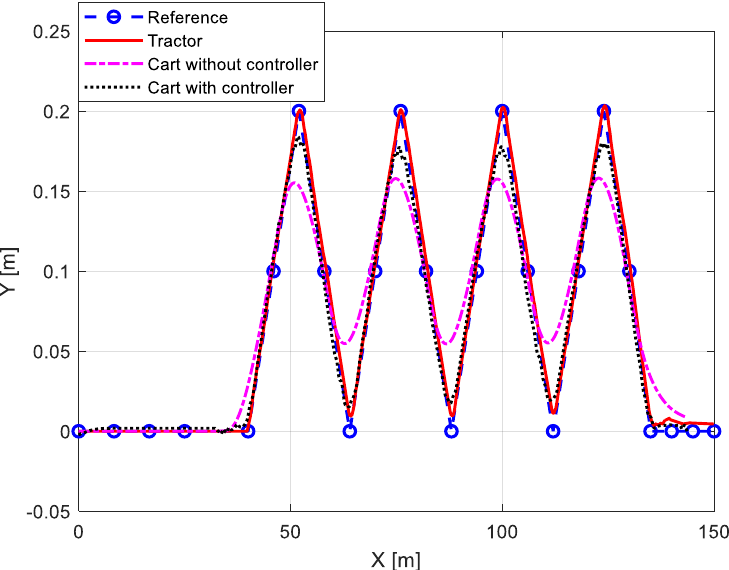
Figure 13 . Performance of tractor-cart position control system under a Zigzag pattern at 5 [m/s] .